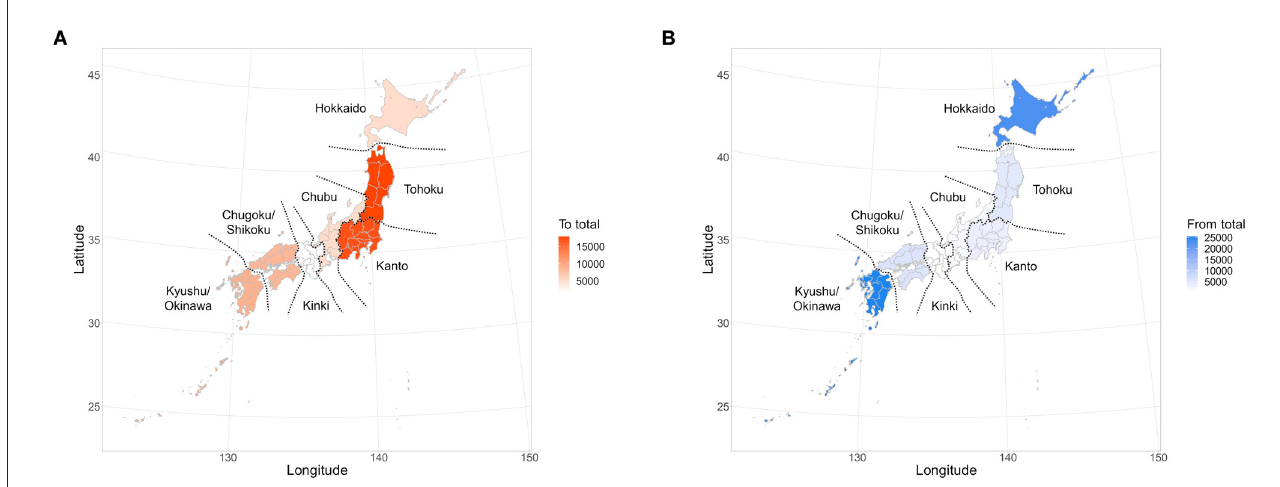
FIGURE1 Classification of Japanese regions in this study and total number of movements of beef cows toward each region (A) and from each region (B) .